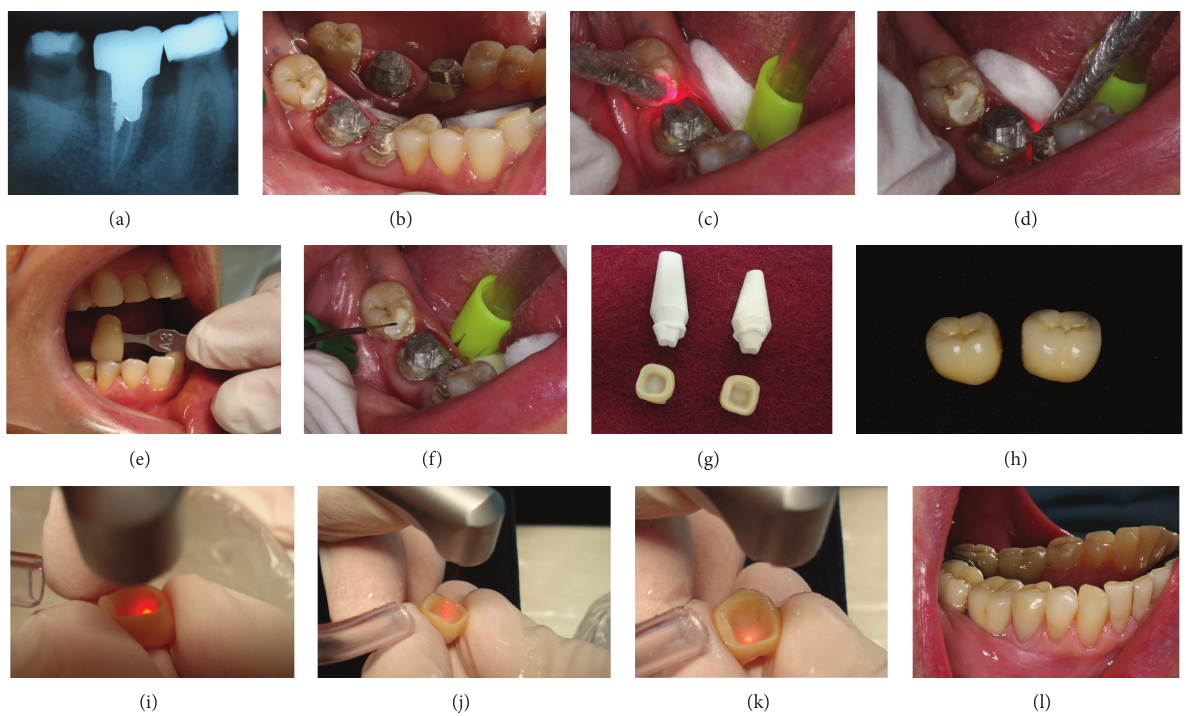
Figure 1: (a) Radiographic exam showing metal-ceramic crowns (teeth 45-46) with unsatisfactory marginal sealing. (b) Metallic posts cementation followed by tooth preparation. (c)-(d) Laser phototherapy (low power laser) applied on periodontal tissues. (e) Selection of tooth color. (f) Microbial reduction using the Nd:YAG laser (1,064nm). (g)-(h) Porcelain restoration (Zircone LAVA, 3 M/ESPE). (i)–(k) Conditioning of the porcelain inner surface using the Er:YAG laser (2,940nm). (l) Final luting of the ceramic restoration.